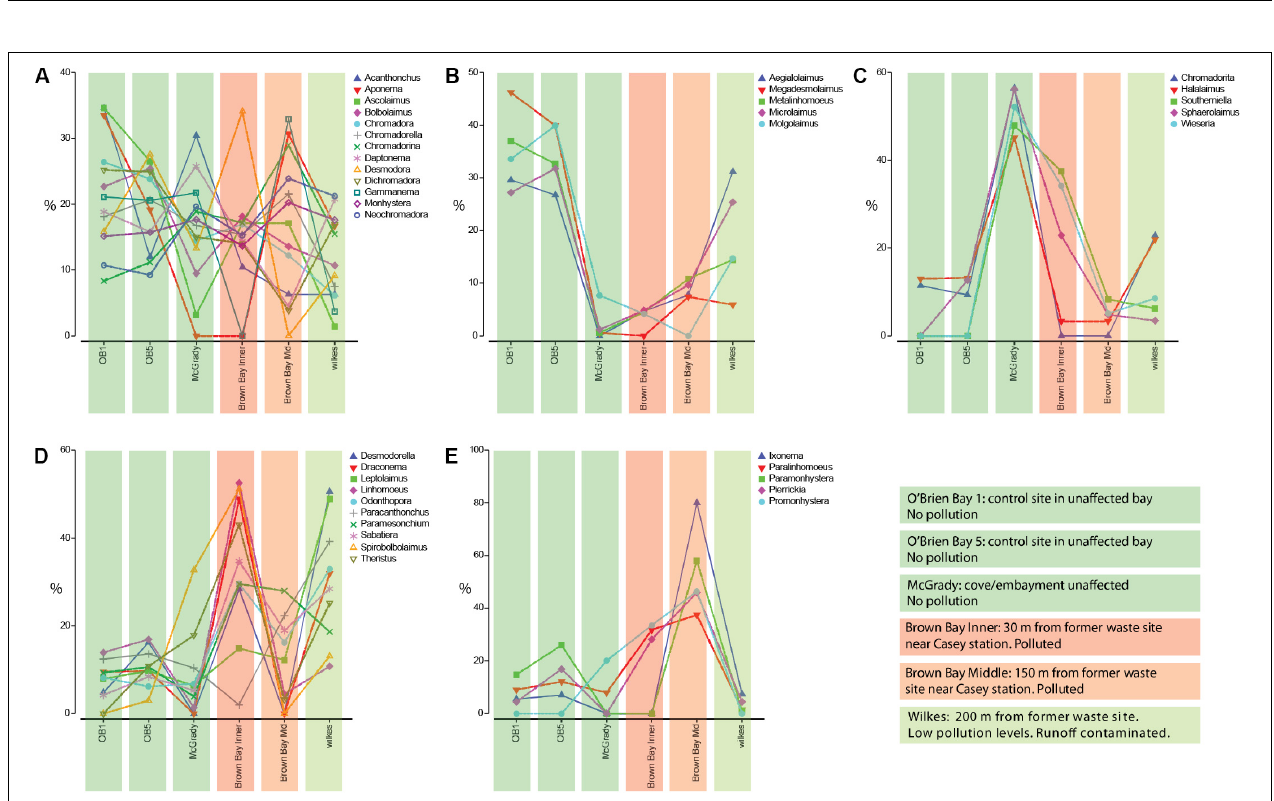
FIGURE 5 | (A–E) Different patterns of abundance from coherance analysis of the 38 nematode genera, standardized by genus across locations, which produced five statistically different subsets of nematode genera. Colored bars are associated with each station and indicate pollution levels as explained in the color legend.